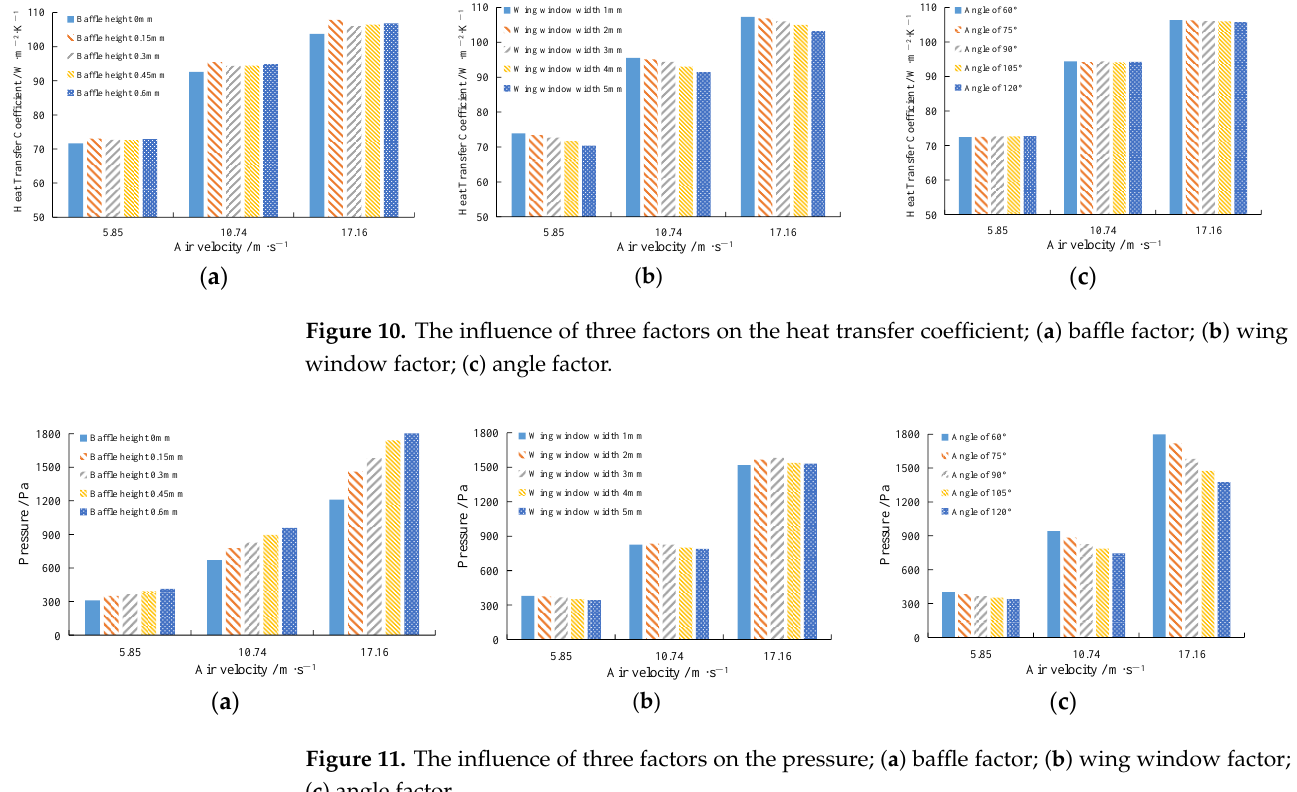
10 of 14 four additional horizontal parameters on the performance of the radiator under low- speed, medium-speed and high-speed operating conditions is discussed. The relationship between the factors and levels is shown in Table 4, and the results are shown in Figures